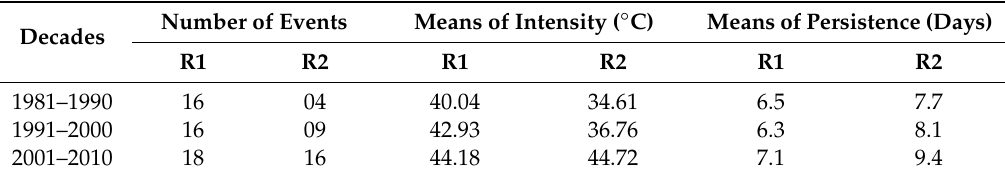
Figure 6. Number of heat wave events per year in regions ( a ) 1 and ( b ) 2 from 1980 to 2013. The red line represents the means of the events. Table 2. Number of heat waves events per decade and decadal means of intensity ( ◦ C) and persistence (days) in region 1 (R1) and region 2